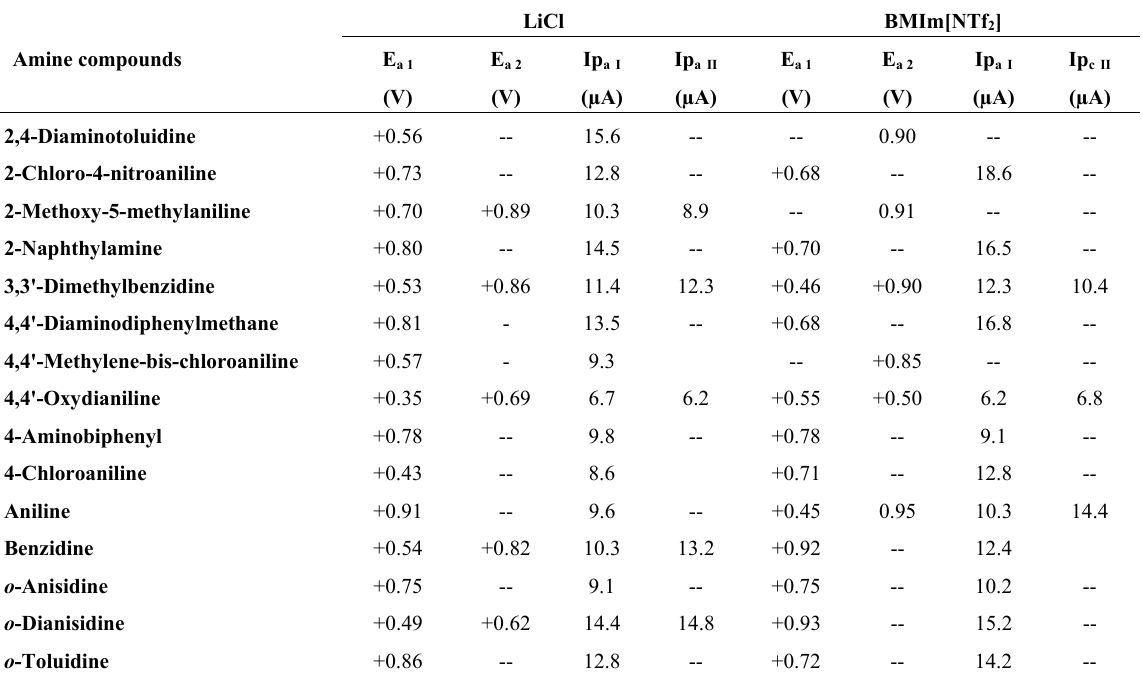
Table 1. Voltammetric parameters obtained for oxidation of aromatic amines at